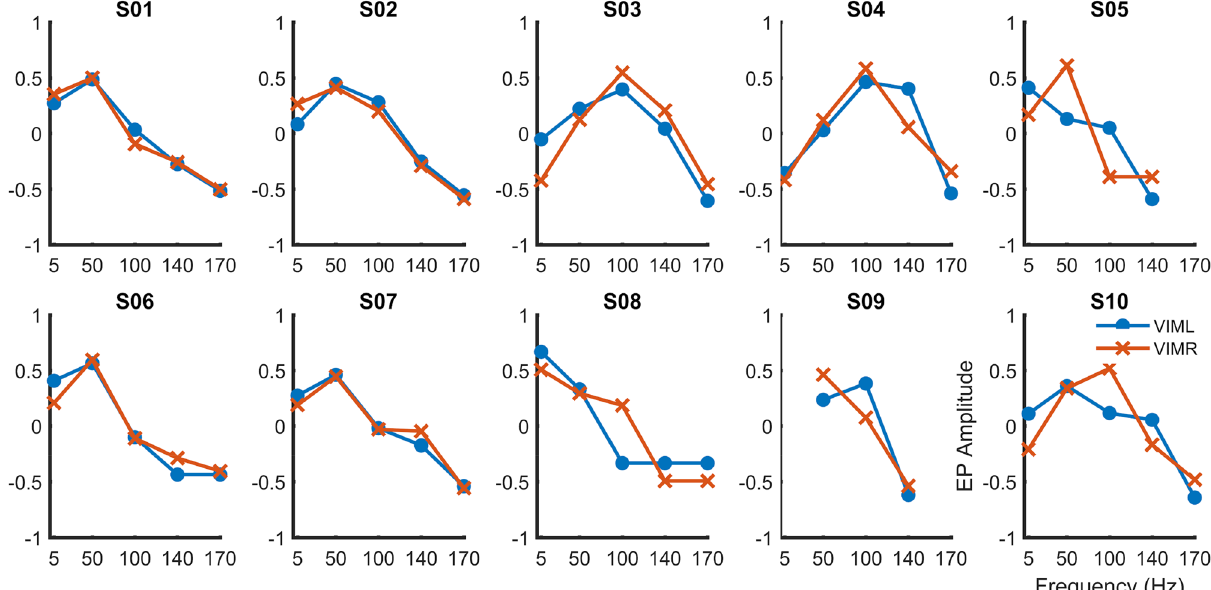
Figure 5. EP amplitudes from left (blue) and right (red) VIM as a function of stimulation frequency during stimulation of the contralateral median nerve, for each subject. Horizontal axes indicate stimulation frequency. Vertical axes represent the normalized EP values.